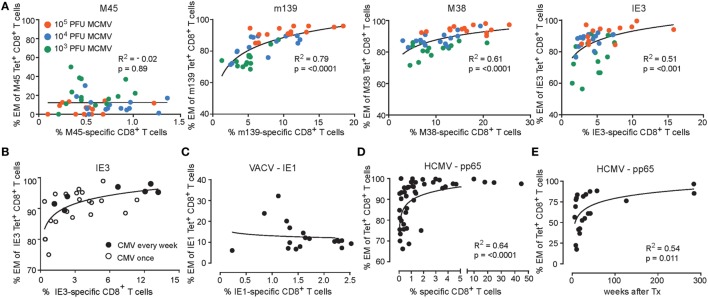
Correlations between the magnitude and phenotype of inflationary CMV-specific T cells. (A) Wild-type (WT) mice were infected with 103, 104 or 105 PFU mouse CMV (MCMV)-Smith. The percentage of MCMV-specific EM (CD44highCD62L−KLRG1+) CD8+ T cells versus the percentage of MCMV-specific CD8+ T cells in blood at day 300 post-infection. Data were pooled from two independent experiments. (B) WT mice were infected with 5 × 104 PFU MCMV-Smith once (n = 20) or weekly (n = 7) for 1 year. At 1 year post-infection, the average frequencies and phenotype of IE3-specific CD8+ T cells in blood was determined by MHC class I tetramer staining. The graph shows the percentage of IE3-specific EM (CD44highCD62L−KLRG1+) CD8+ T cells versus the percentage of IE3-specific CD8+ T cells in blood. (C) WT mice were infected with recombinant vaccinia virus expressing IE1 (VACV-IE1). At day 200 post-infection, the average frequencies and phenotype of IE1-specific CD8+ T cells in blood was determined by MHC class I tetramer staining. The graph shows the percentage of IE1-specific EM (CD44highCD62L−KLRG1+) CD8+ T cells versus the percentage of IE1-specific CD8+ T cells in blood (n = 18). (D) Analysis of human cytomegalovirus (HCMV)-specific CD8+ T cell responses. The percentage of antigen-specific EM CD8+ T cells versus the percentage of antigen-specific CD8+ T cells in blood from healthy donors for HCMV pp65 (n = 46). (E) The percentage of antigen-specific EM CD8+ T in blood from initially HCMV-seronegative recipients receiving a HCMV-positive kidney transplant against the weeks after transplantation.